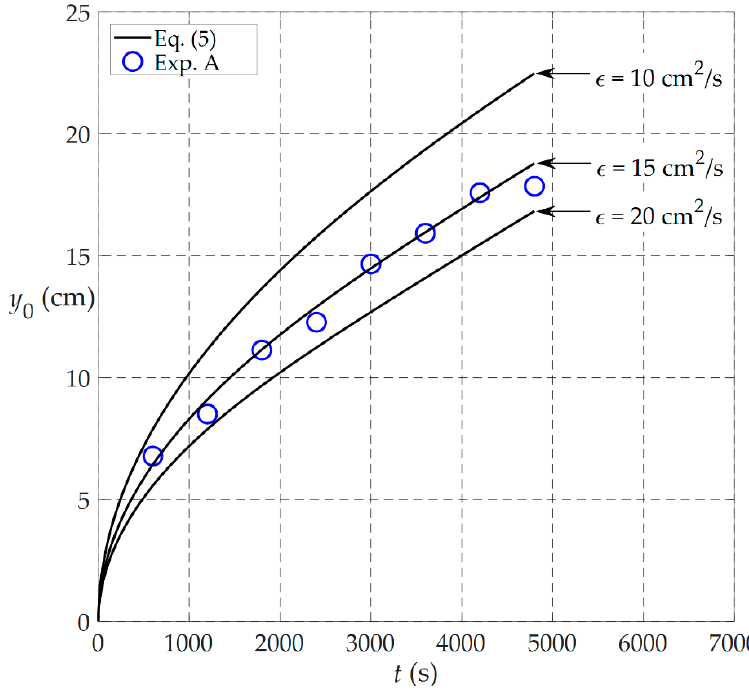
Figure 9. Calibration of ε for the experimental data from the study of [2].